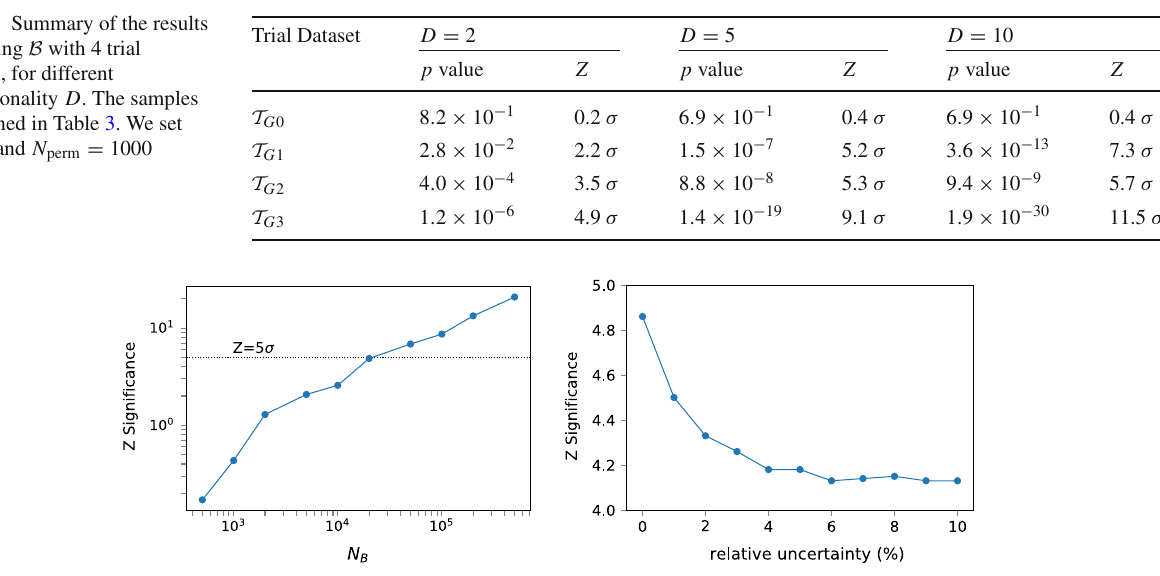
uncertainties added to B only, with fixed N B = N T = 20 , 000. The U distribution has been computed with N iter = 1000 random samplings from the distribution of feature